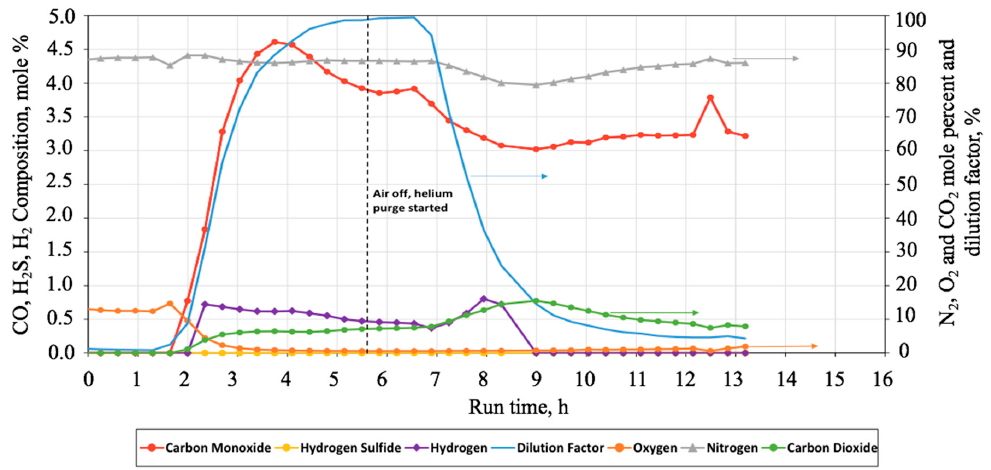
Figure 9. Reverse Combustion Produced Combustion Gas Compositions (Color should be used).